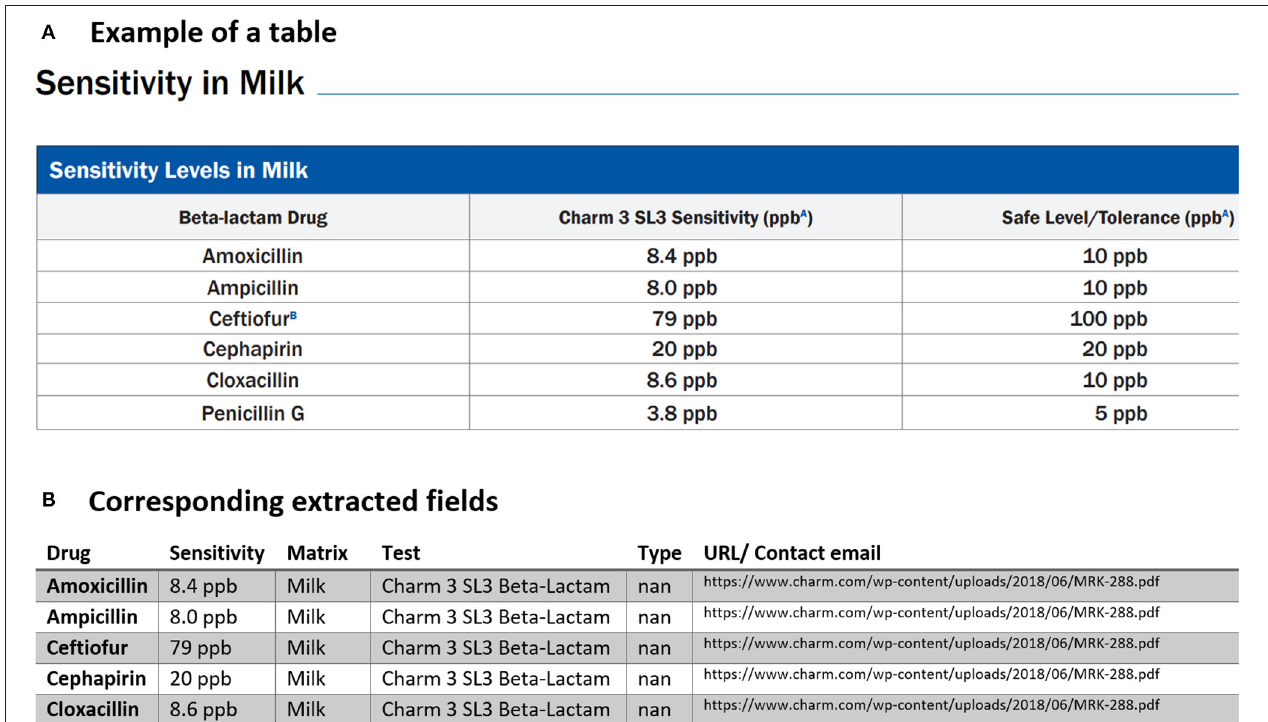
FIGURE 4 | An example of data table extraction for “Charm Flunixin and Beta-Lactam” and the corresponding fields cleaned in a table.